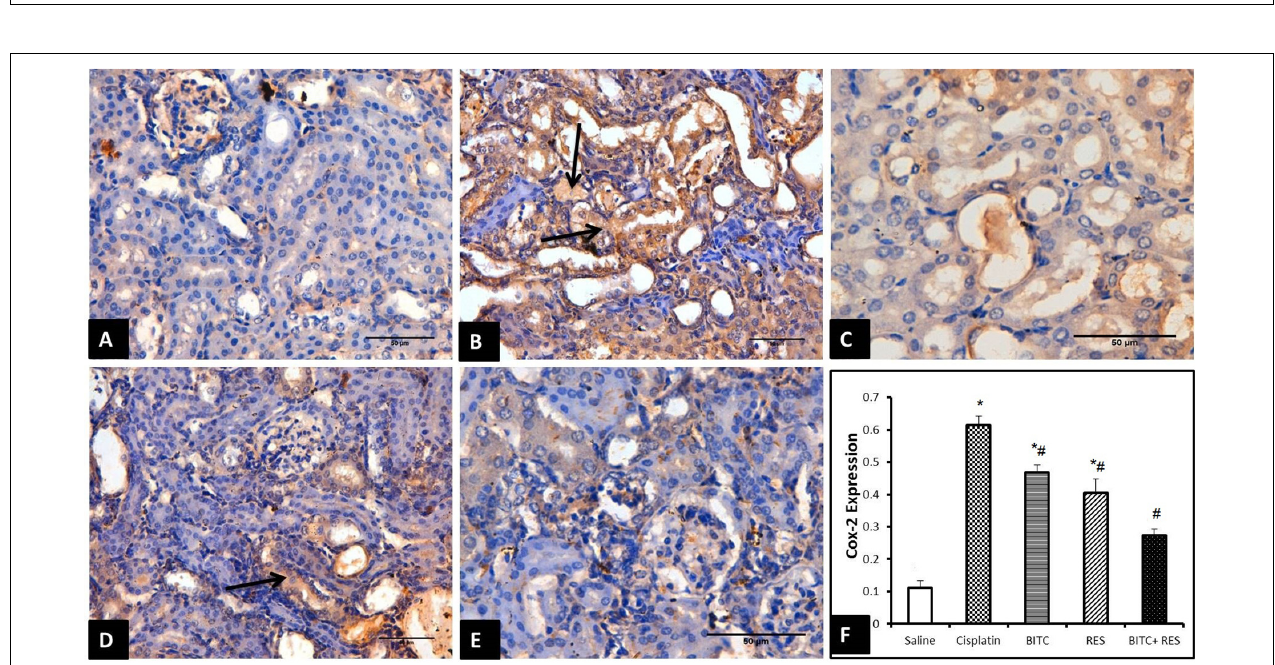
FIGURE 6 | COX-II immunohistochemical examination (Bar = 50 µ m) of renal tissue samples from (A) saline-treated mice showing minimal COX-II expression, (B) cisplatin-intoxicated mice revealing many Cox-II-positive epithelial cells (arrows), (C) cisplatin-intoxicated mice treated with RES and (D) cisplatin-intoxicated mice treated with BITC showing moderate reductions in COX-II-positive cells (arrow), and (E) cisplatin-intoxicated mice treated with a combination of RES and BITC showing minimal COX-II expression. (F) Quantitative Cox-II expression in the cytoplasm of renal epithelial cells ( ∗ significantly different from the normal control group at p < 0.05, # significantly different from the CDDP group at p <